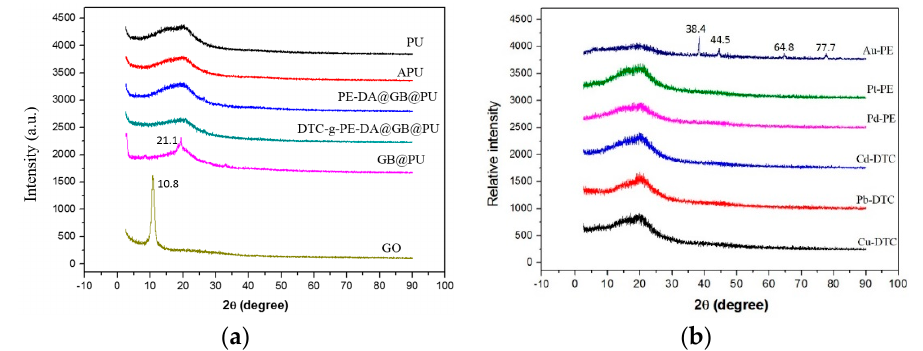
Figure 9. WAXD patterns for ( a ) PU, APU, GB@PU, PE-DA@GB@PU, DTC-g-PE-DA@GB@PU, and GO; ( b ) after Cu 2 + , Pb 2 + , and Cd 2 + adsorption on the DTC-g-PE-DA@GB@PU and Pd 2 + , Pt 4 + , and Au 3 + adsorption on the